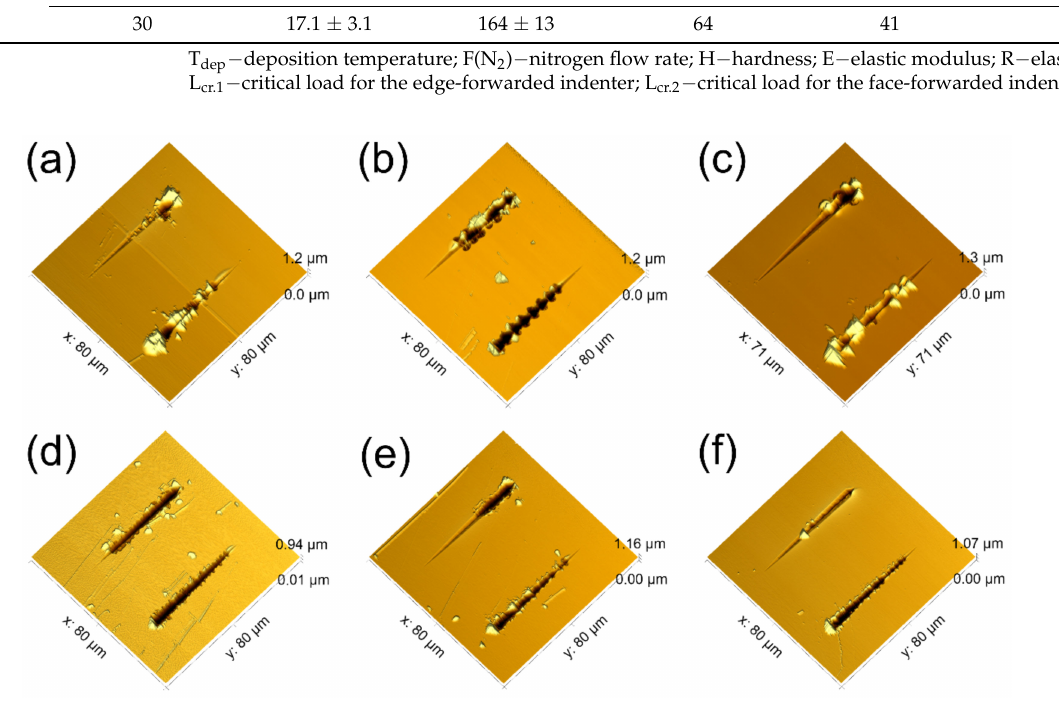
Figure 10. AFM images of scratches on the surface of SiC x N y films obtained at ( a , b , c ) room temperature and ( d , e , f ) 300 ◦ C and nitrogen flow rate of ( a , d ) 0, ( b , e ) 15 and ( c , f ) 30 sccm. Different attack angles correspond to different deformation modes. The edge-forward ori- entation is close to plastic extrusion, while the face-forward orientation is close to microcutting. This is also manifested in the relief characteristics after the tests (formation of piles at the scratch edges as the tip moves in first and second orientation modes). In this case, no significant exfoliation of the films from the substrates was observed. The data of Table 8 show that sample SiC 0.87 N 2.02 , prepared at RT and 30 sccm of nitrogen flow rate, exhibit the strongest resistance to plastic extrusion, while all samples of this series (T dep = 25 ◦ C) are subject to a different type of deformation, microcutting, to almost the same